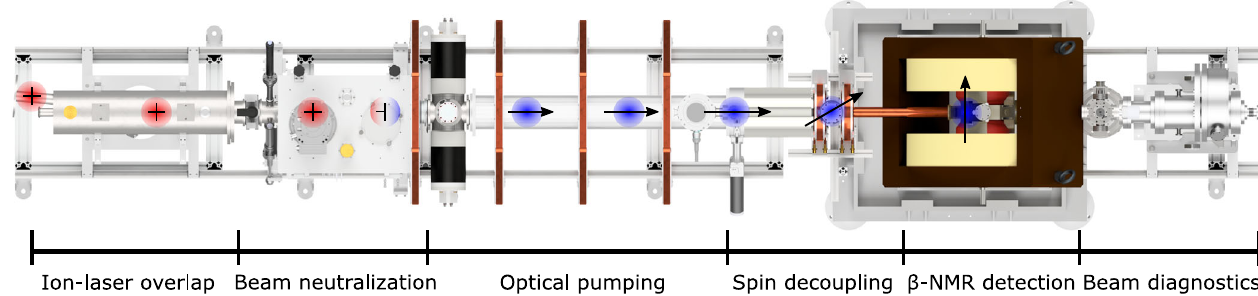
1. Top view of the laser polarization and β -NMR beam line [61,62]. The ion and laser beams enter from the left. The ions are represented by red circles with a plus sign. The neutral atoms are represented by blue circles. The polarization of the atom is represented by arrows. See the text for further